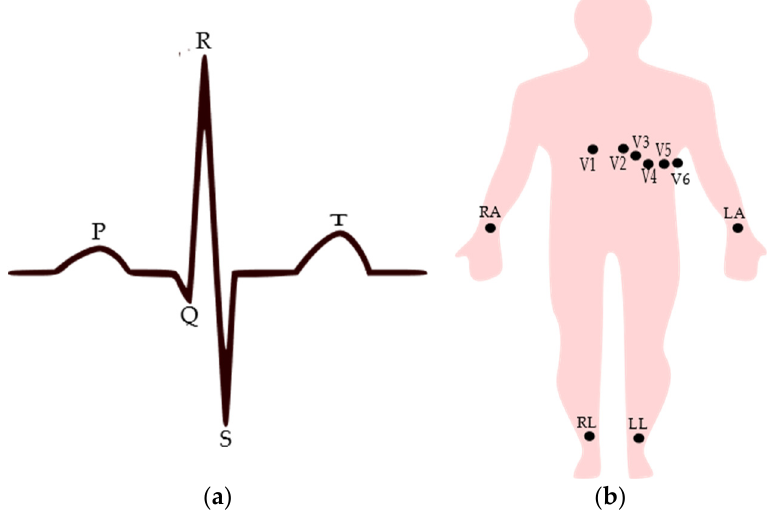
Figure 1. ( a ) Typical normal ECG signal with major components from Lead I configuration; ( b ) electrode placement for standard clinical ECG measurement, where V is the voltage, RA is the right arm, LA is the left arm, RL is the right leg, and LL is the left leg electrodes.